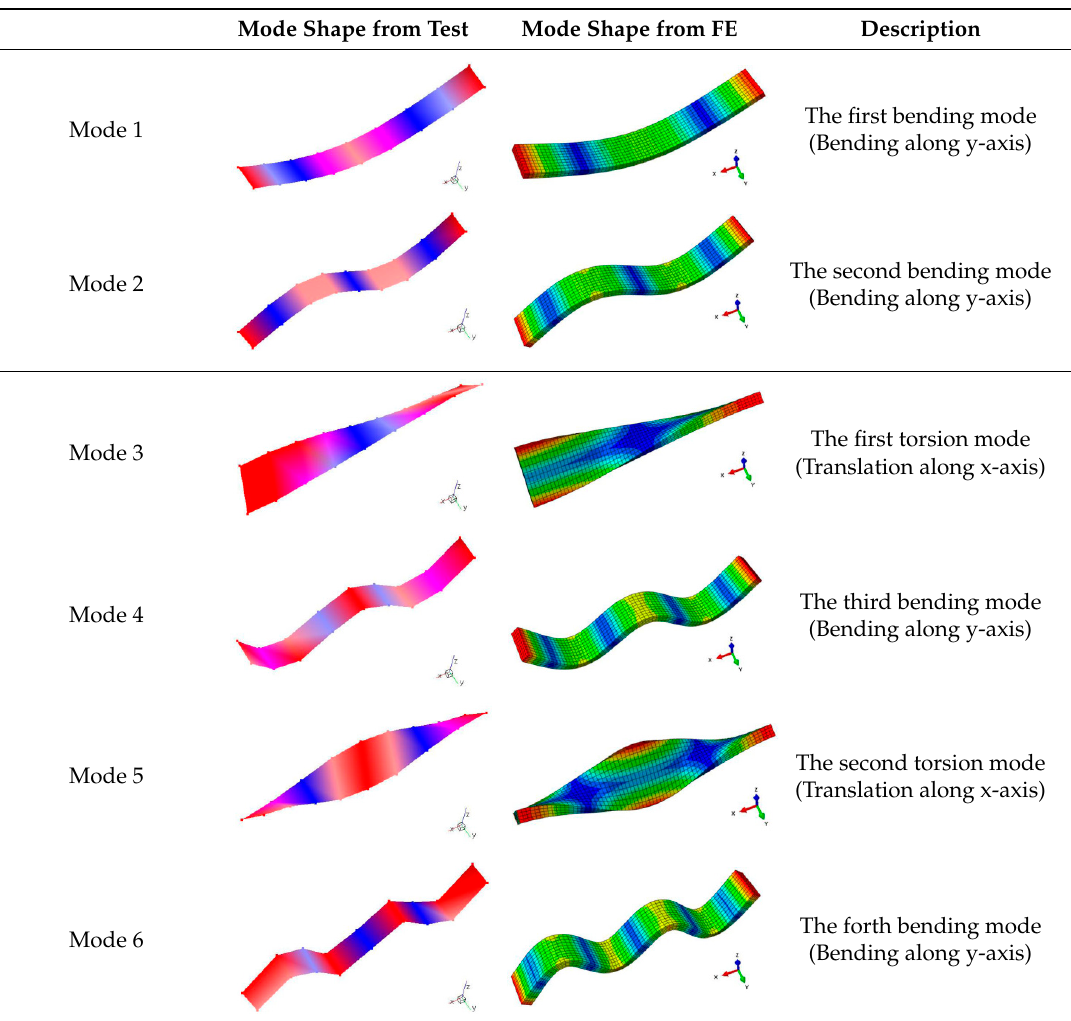
Table 3. The modal shape from experiment and FE.